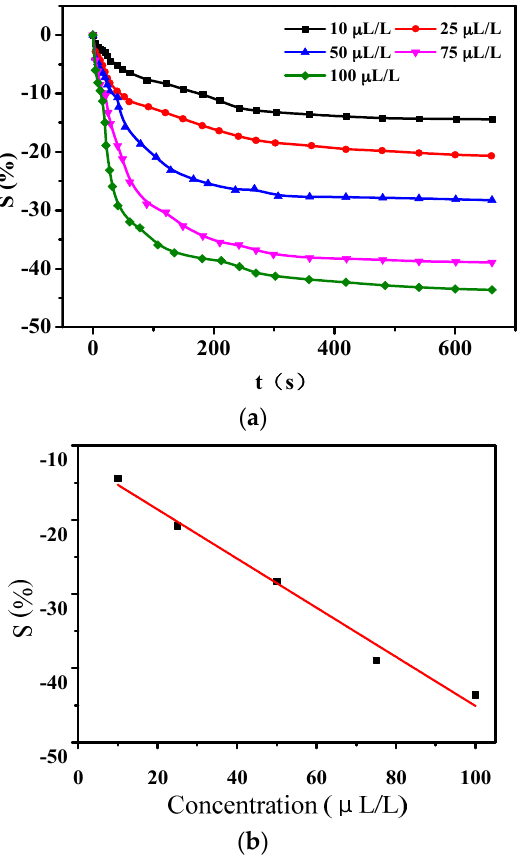
Figure 11. Gas-sensing response of PANI-HCl/SSA sensor to SO 2 of different concentration. ( a ) Response to various concentration of SO 2 ; ( b ) Liner dependence between sensitivity and gas concentration.